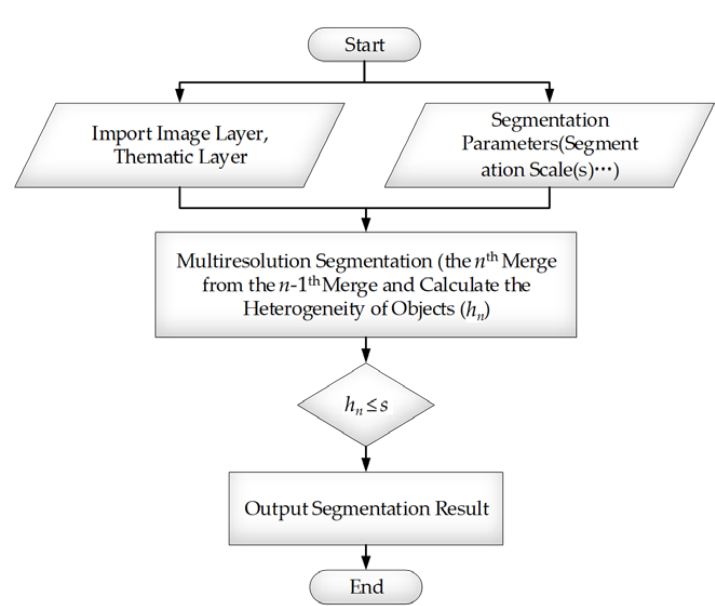
Figure 3. Schematic diagram of multiresolution segmentation algorithm.